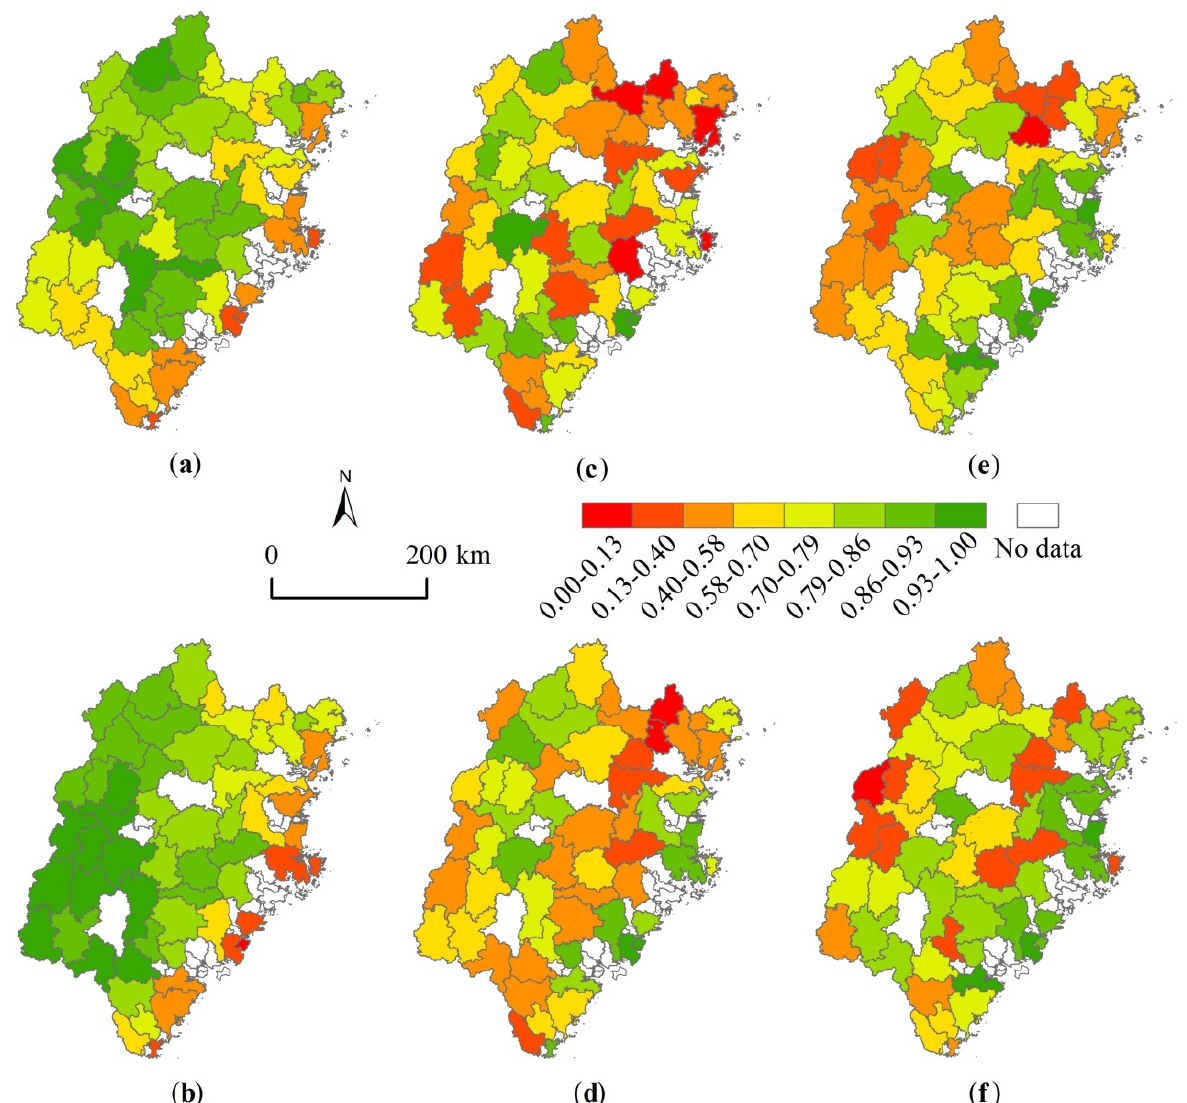
Figure 2. Evolution of EI and EC and TR in Fujian province in 2000 and 2018. ( a ) EI of 2000; ( b ) EI of 2018; ( c ) EC of 2000; ( d ) EC of 2018; ( e ) TR of 2000; ( f ) TR of 2018.